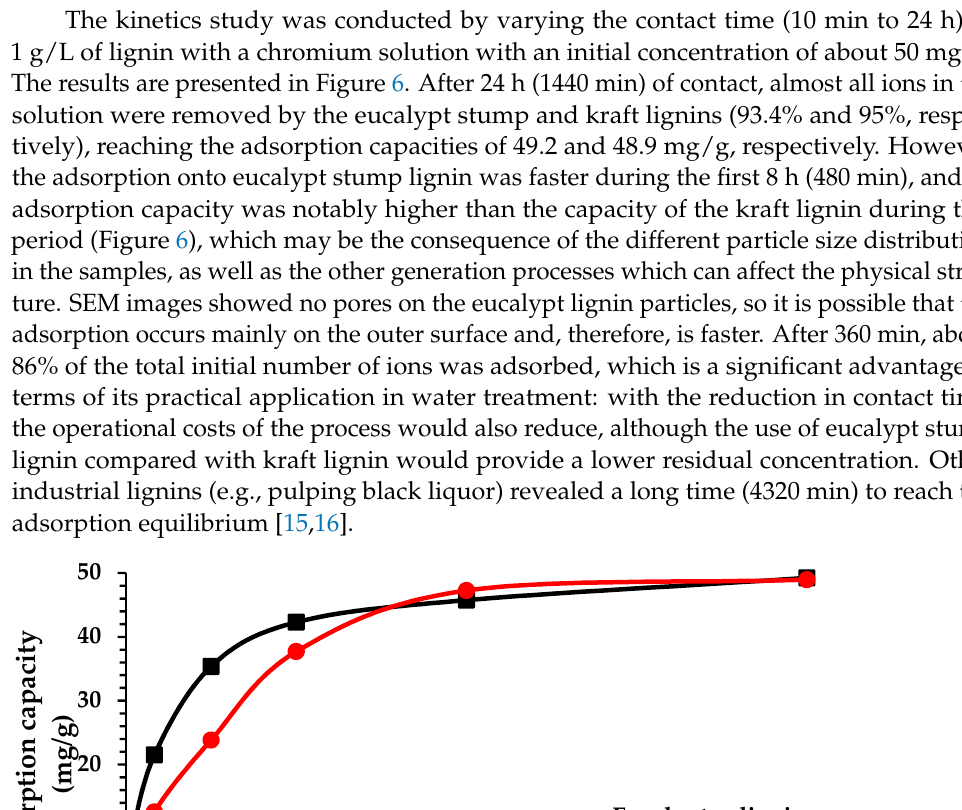
Table 3. Parameters of kinetic and diffusion models for Cr(VI) adsorption onto eucalypt stump and kraft lignin.